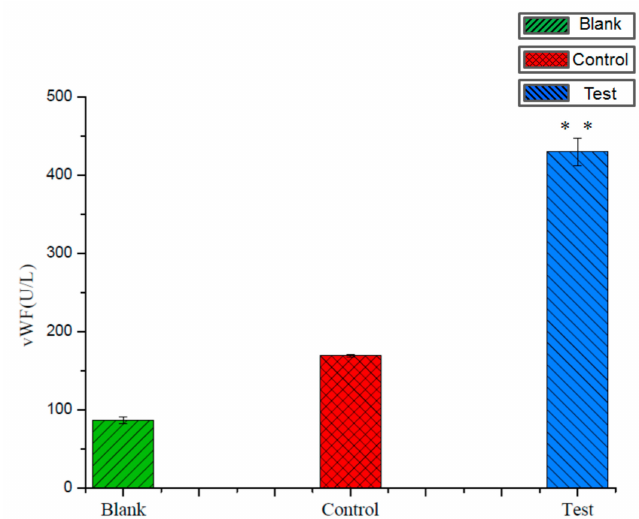
Figure 7. Cell-derived vWF (von Willebrand factor) activity assay: The cells at the bi-conical vessel with flow running for 24 h were designated as a test group, whereas the cells at the straight vessel with flow running for 24 h were designated as a control group. Untreated cells were used as a blank